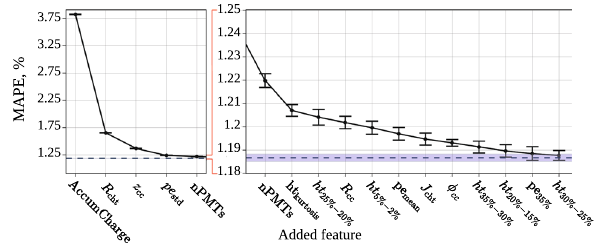
Fig. 10 Dependence of the effective resolution ˜ a and RMSE on the